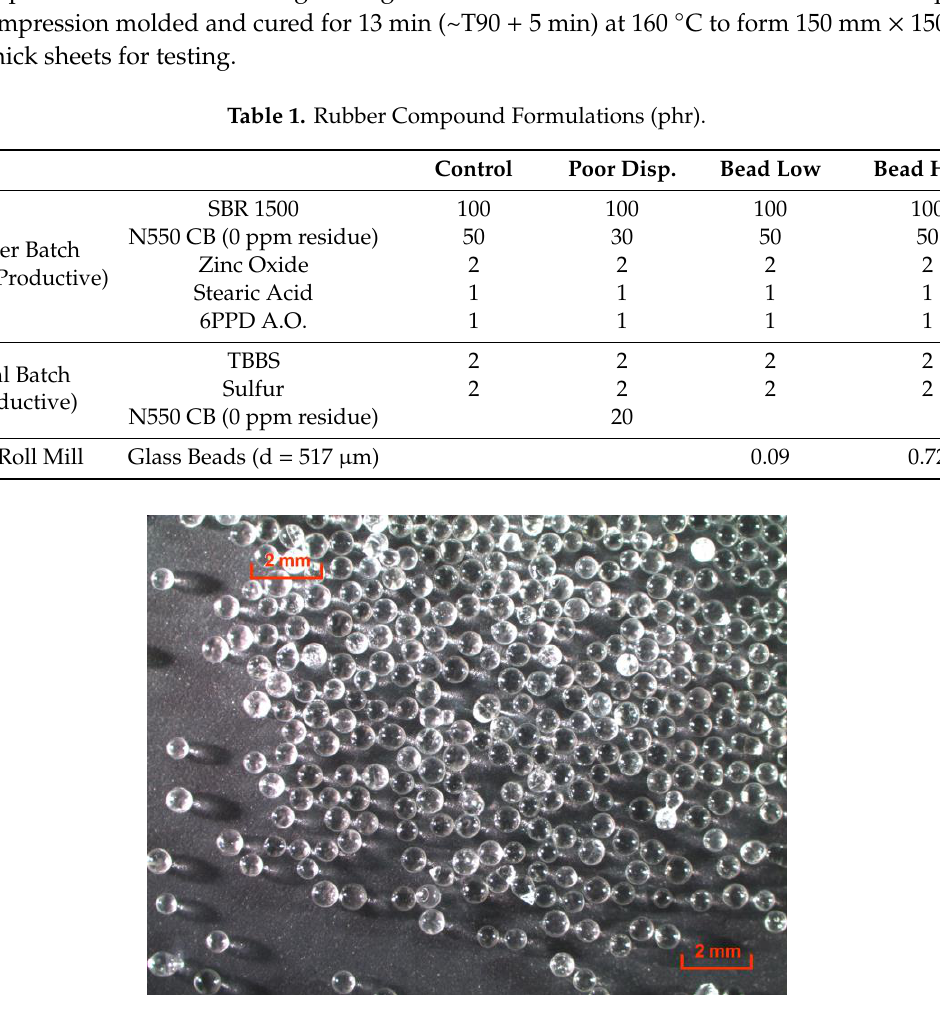
Figure 1. Optical microscope image of glass beads used in this study.